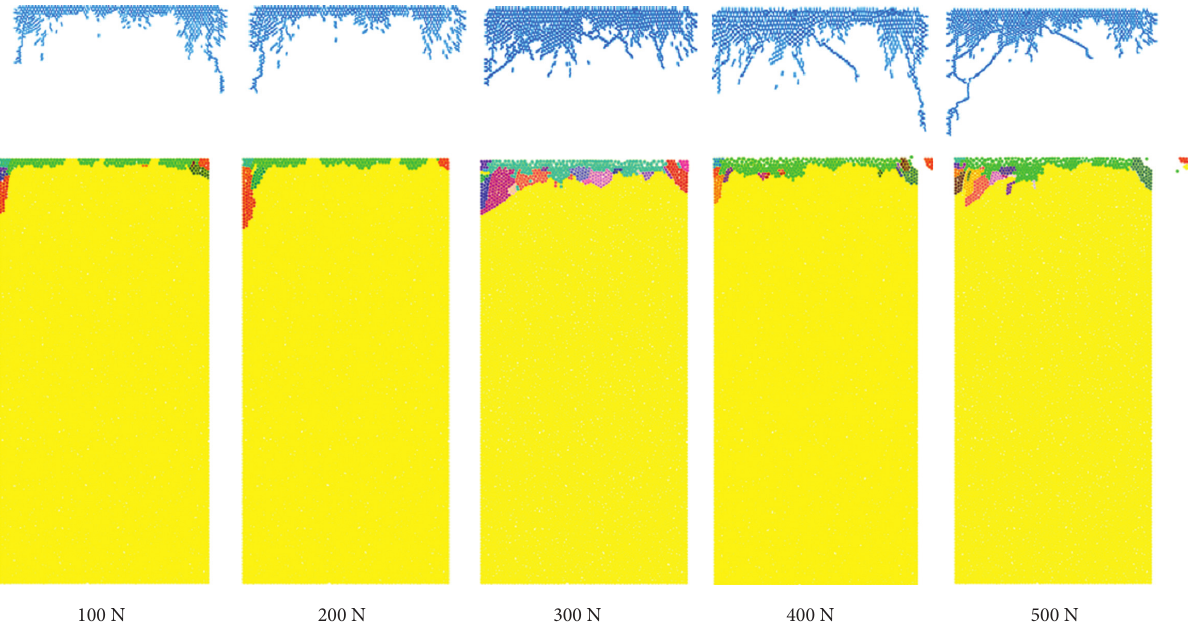
Figure 2: Rock crack distribution characteristics and failure morphology.